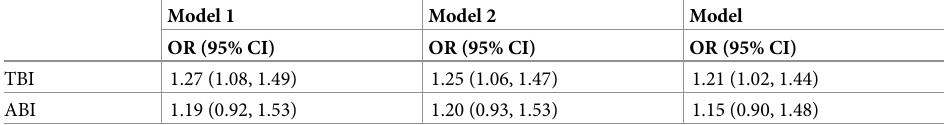
Table 3. Logistic regression analysis on relationship between ABI/TBI (0.1 unit) and high